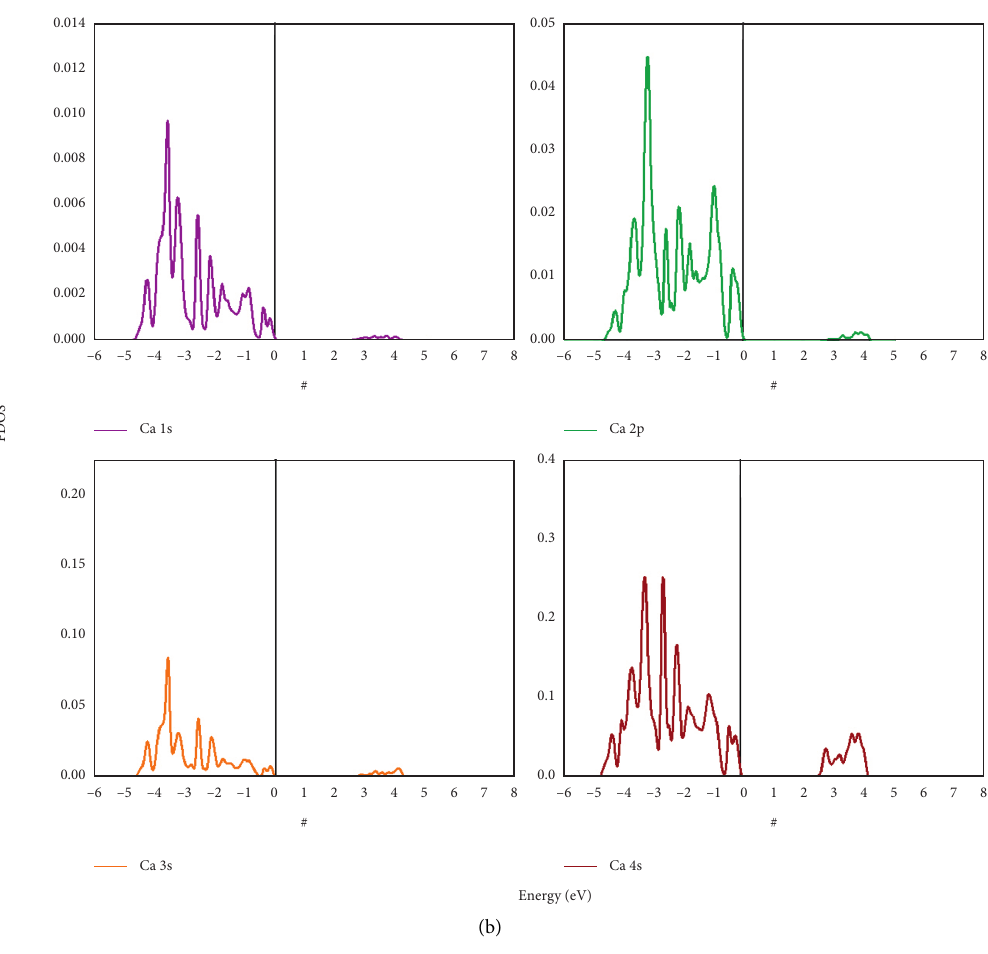
Figure 9: (a) Mg dopant states and (b) Ca dopant states in brookite.